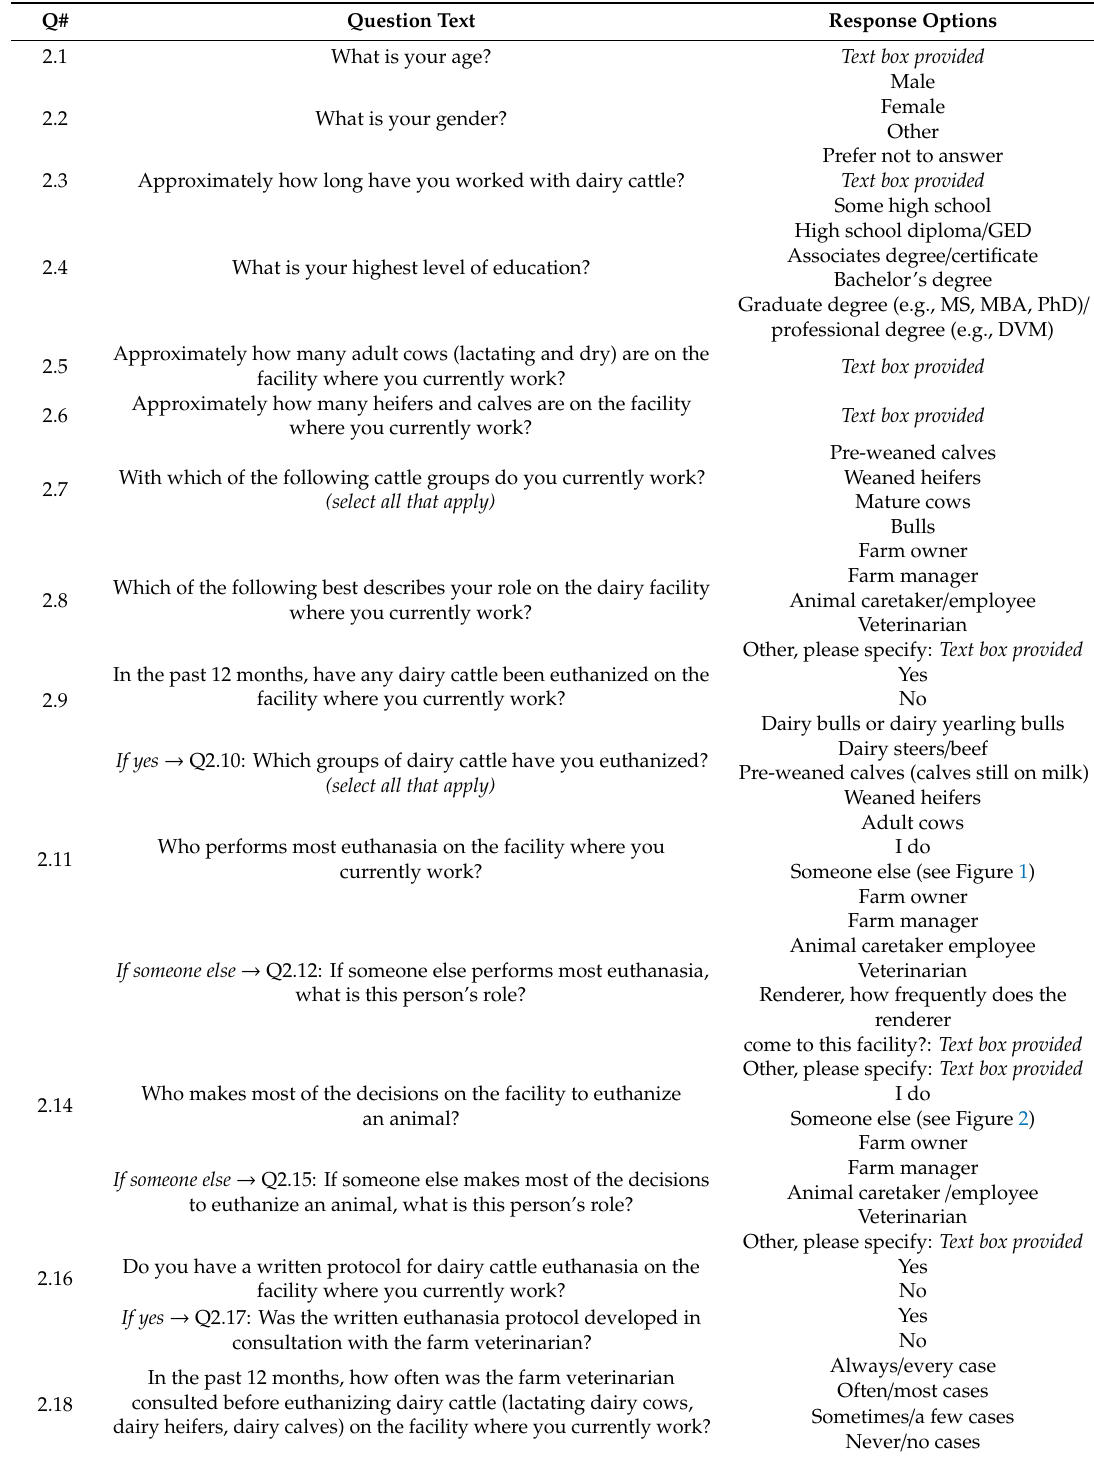
Table A1. Survey questions used to attain respondent and farm demographic information, including the response options provided for each